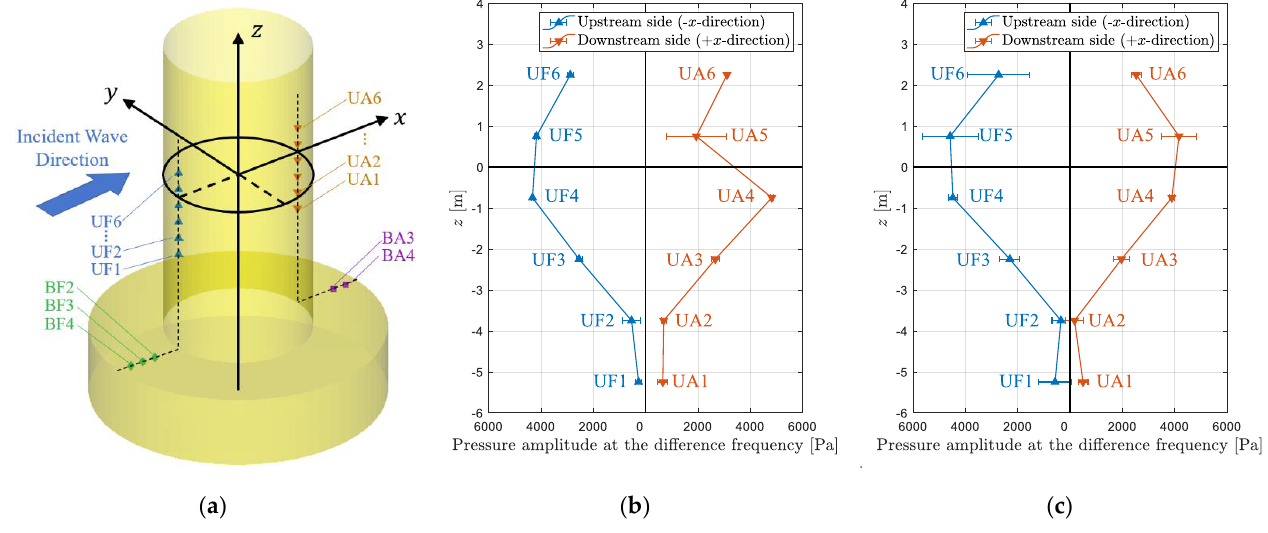
Figure 16. Pressure measurements. ( a ) shows the locations of the pressure taps (symbols). Example measurements on ( b ) the upstream column and ( c ) the starboard column near the waterline are shown for configurations P/N and bichromatic wave B4. In ( b , c ), the amplitudes of pressure oscillation at the difference frequency from fast Fourier transforms of the pressure time series are shown. The horizontal uncertainty bars are the 95% − confidence random uncertainties estimated from the three repeated trials. All values are at full scale.